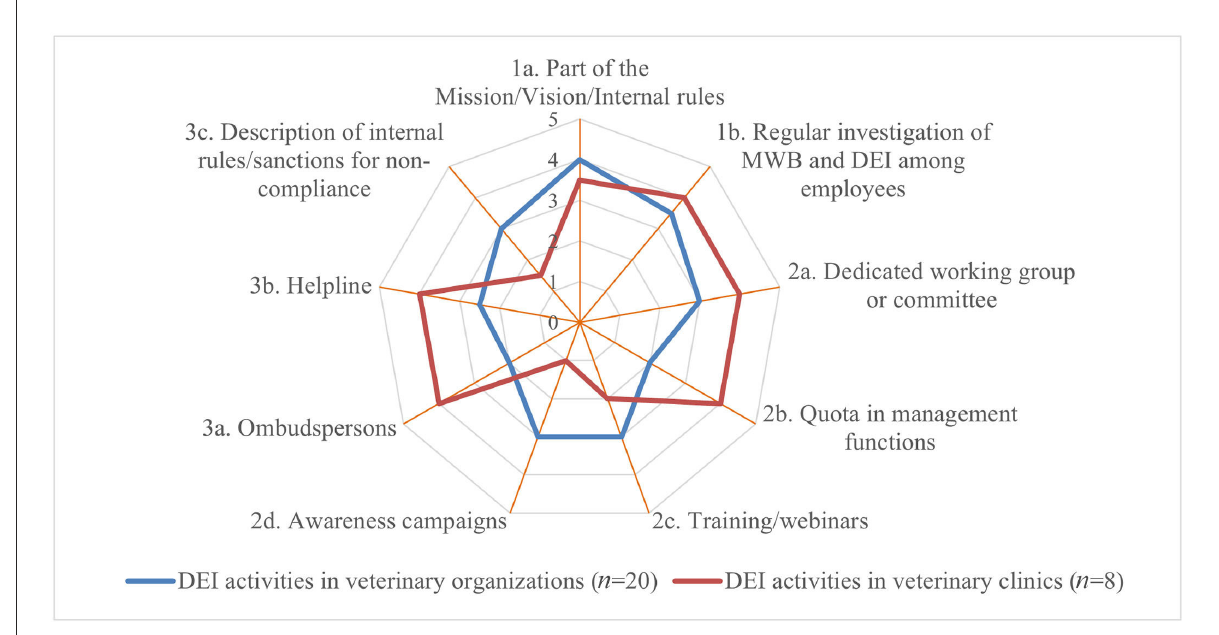
FIGURE6 Perceived median impact of different DEI implementation strategies per tier and per respondent group (where 1 implied no impact and 5a very positive impact) based on the survey responses.